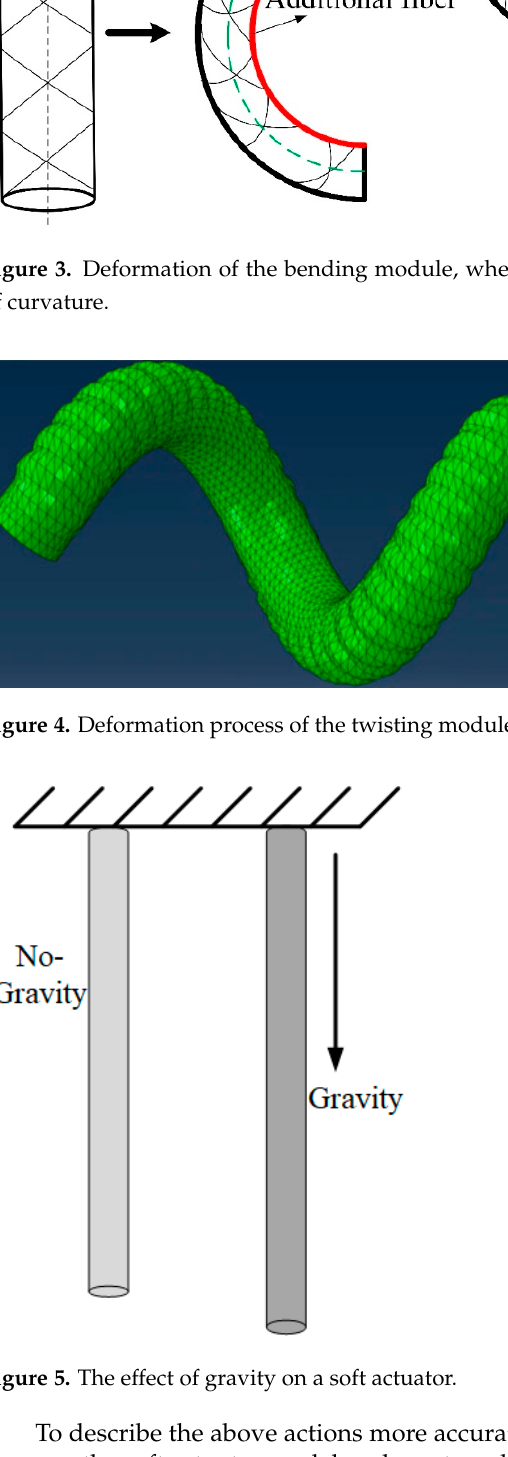
Figure 3. Deformation of the bending module, where of curvature.